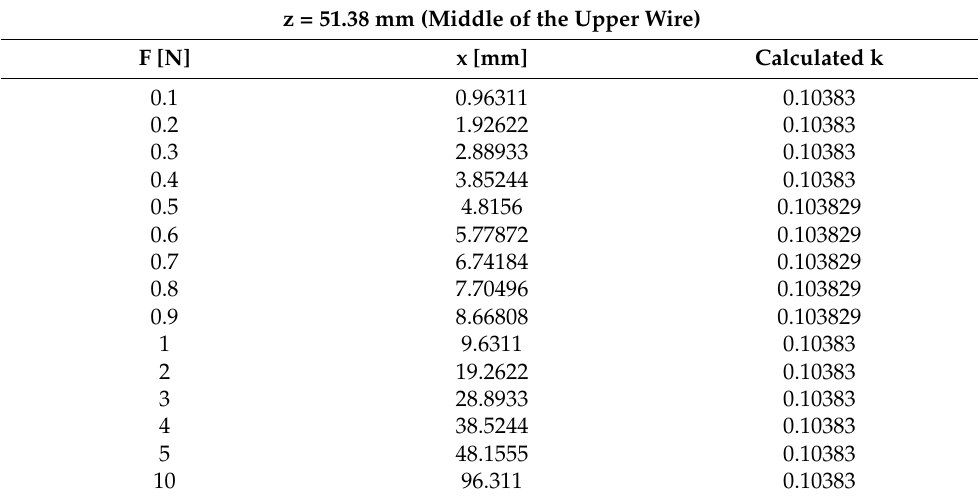
Table 4. Simulation values for z = 51.38 mm (middle of upper wire) and force F from 0.1 to 10